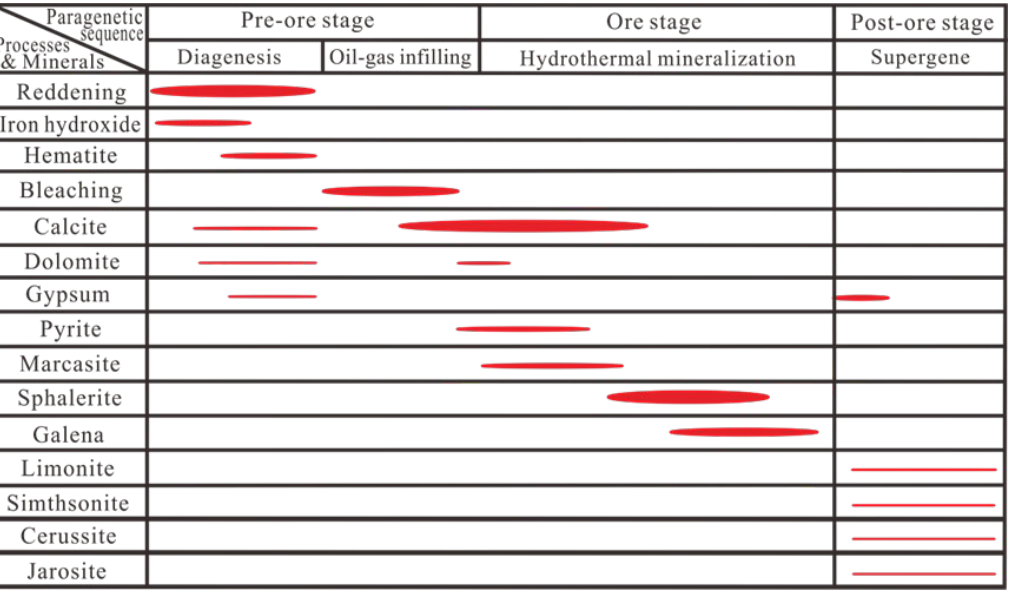
Figure 4. Paragenetic sequence of ore and gangue minerals from the Uragen Zn–Pb deposit (modified after [13]).